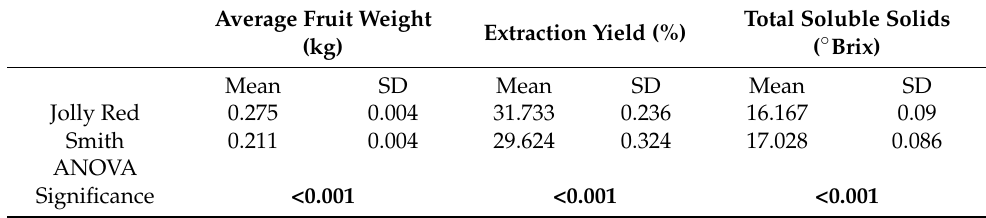
Table 1. Fruit characterization—comparison between the two cultivars. Results of ANOVA are also reported ( p -values *) Average Fruit